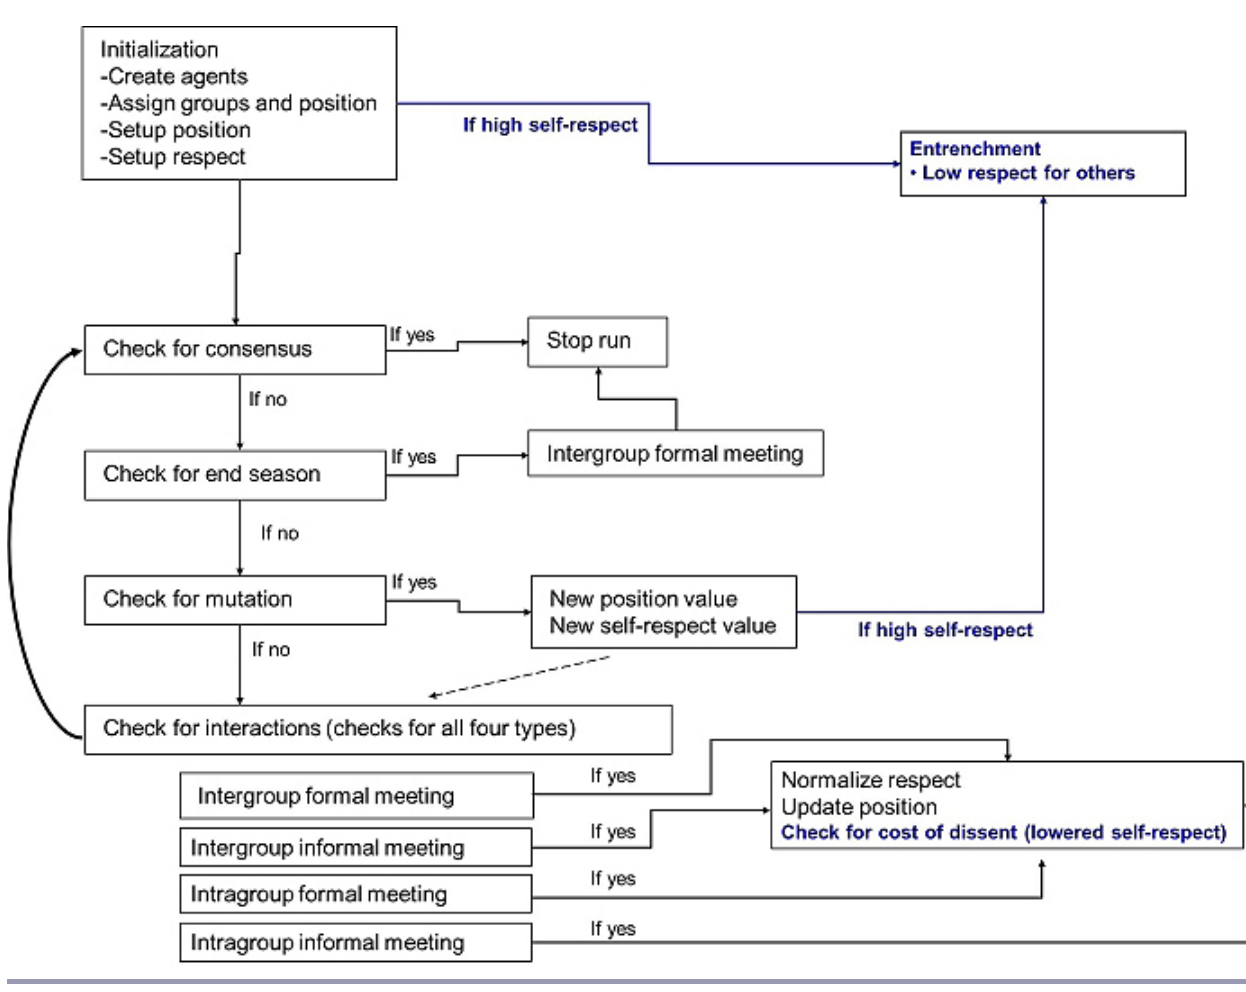
Fig. 3 . Order of events in the model. (Base version in black, complex version in